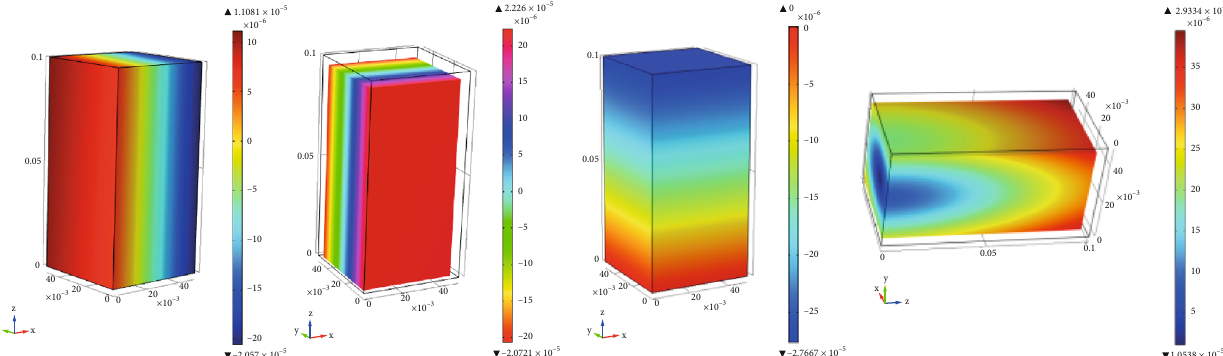
Figure 1: The change of displacement fi eld of coal body. (1) X displacement fi eld. (2) Y displacement fi eld. (3) Z displacement fi eld. (4) Change of total displacement fi eld.